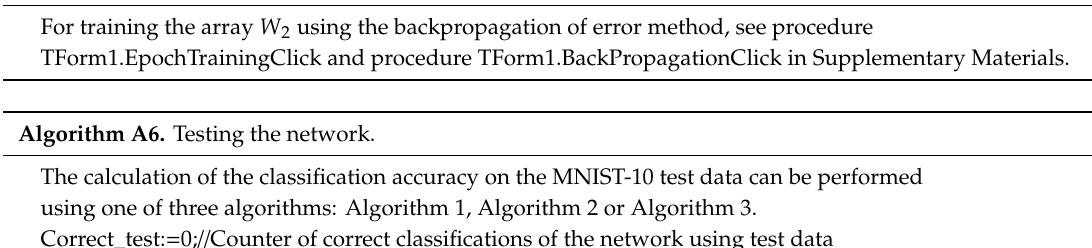
Algorithm A5. Training the array W 2 using the backpropagation of error method.